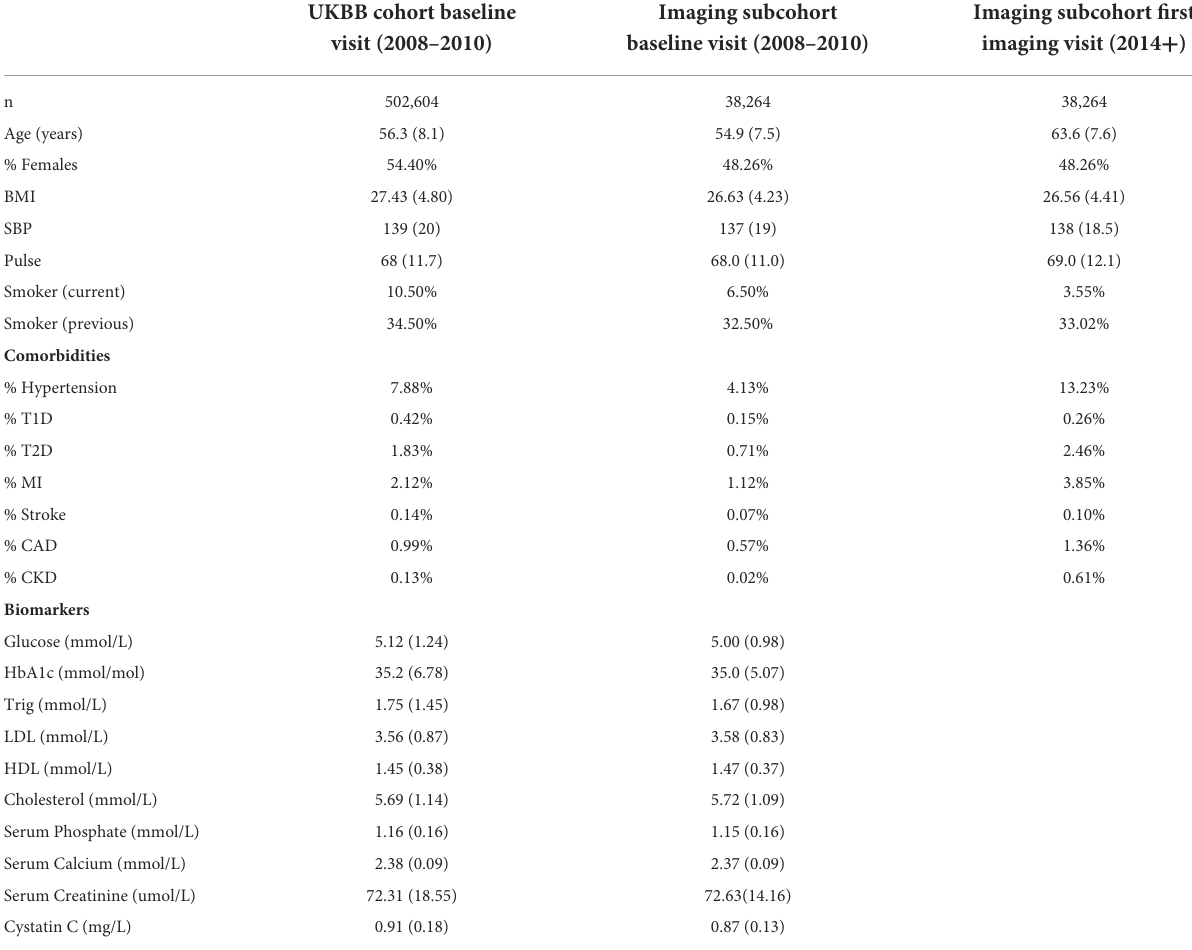
TABLE 1 Baseline characteristics of the UK Biobank (UKBB) cohort and the calcification